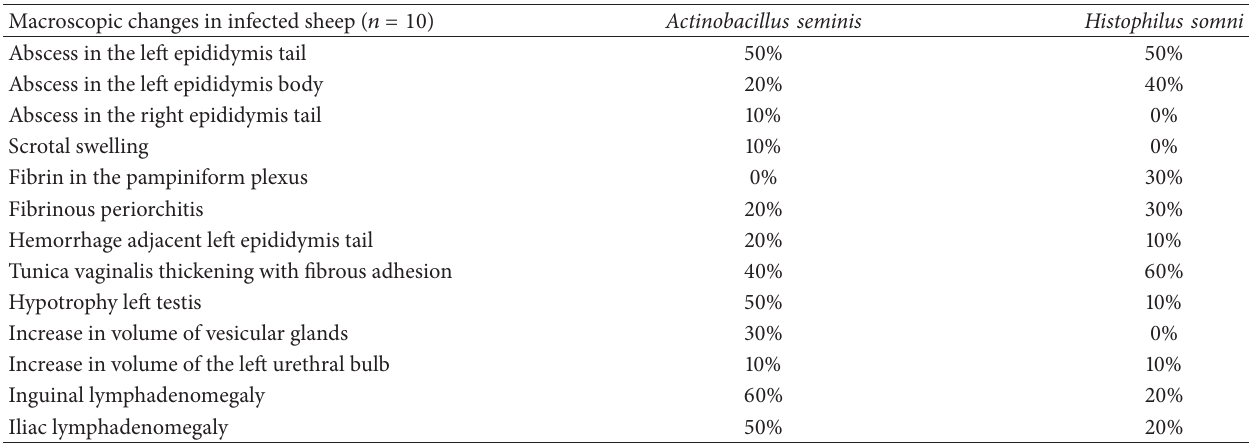
Table 2: Frequency (%) of gross changes in rams experimentally infected with Actinobacillus seminis or Histophilus somni . Macroscopic changes in infected sheep ( 𝑛 = 10 ) Actinobacillus seminis Histophilus somni Abscess in the left epididymis tail 50% 50% Abscess in the left epididymis body Abscess in the right epididymis tail